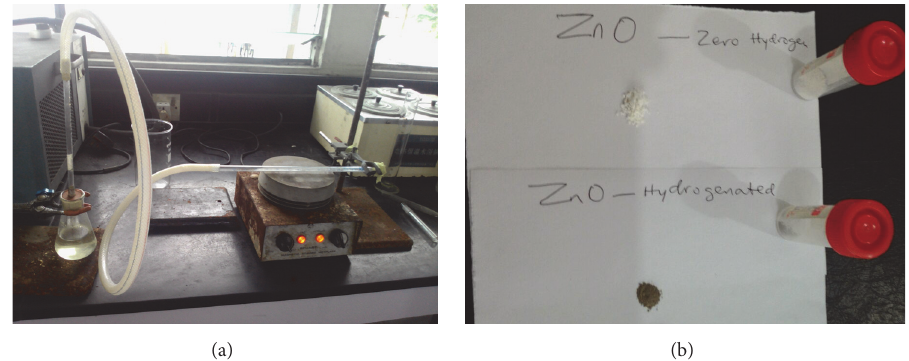
Figure 1: (a) Hydrogenation of ZnO heated at 55 ∘ C using Mg ribbon dissolved in 6 M HCl and (b) labelled samples before and after